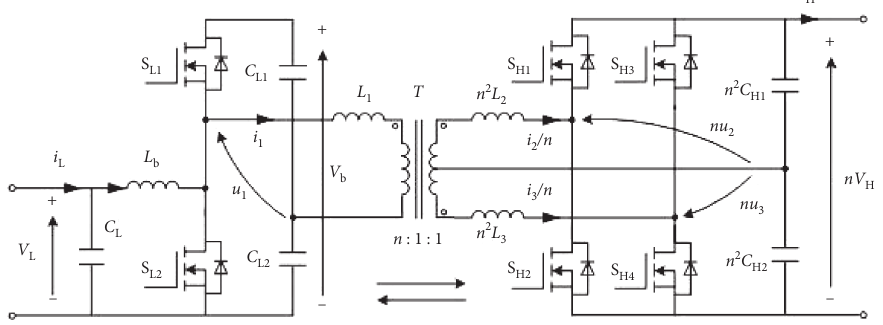
Figure 3: CF-IBDC topology.